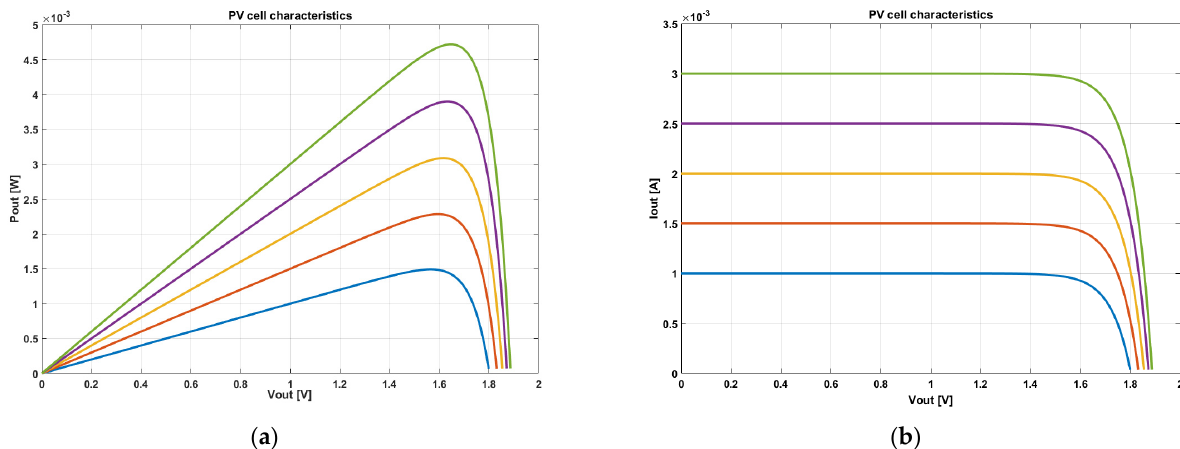
Figure 2. ( a ) Power/voltage curve of PV; ( b ) Current/voltage curve of PV.